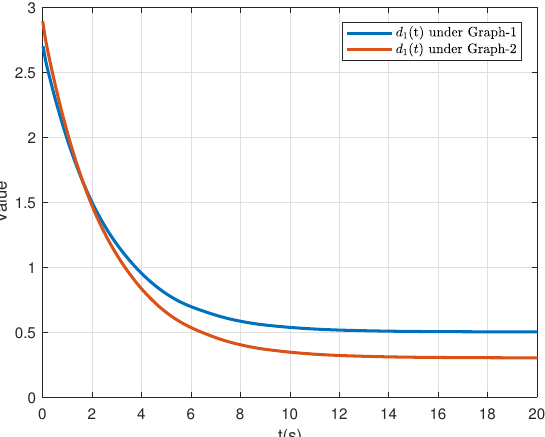
Figure 8. The time-varying threshold d 1 ( t ) of agent-1 under G 1 and G 1